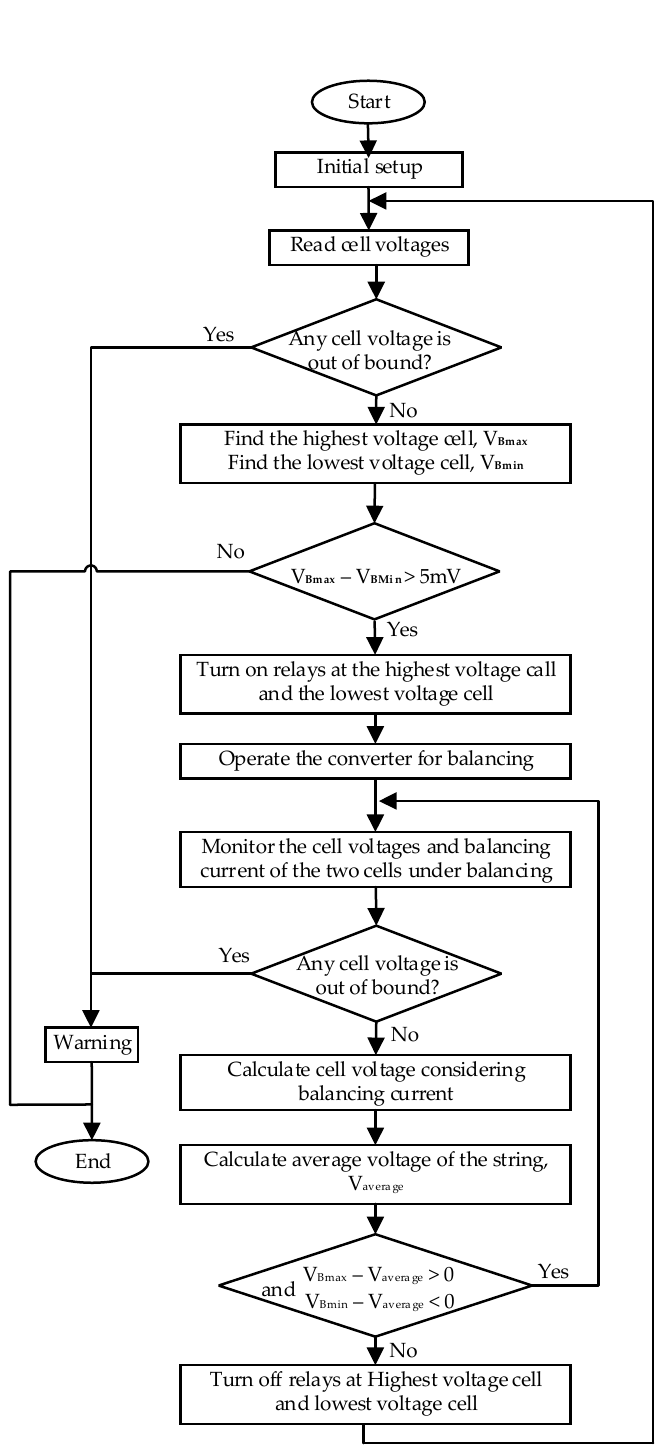
Figure 5. Balancing algorithm of the proposed method.